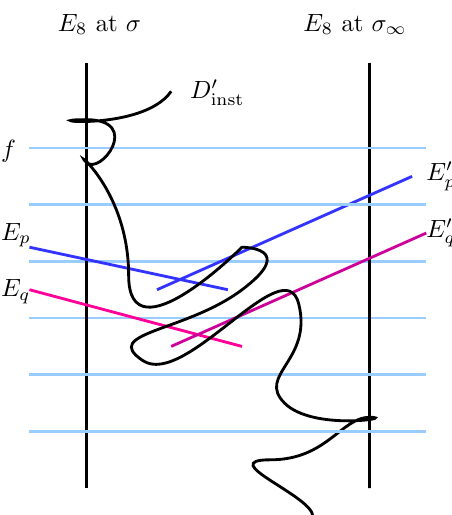
Figure 5. Two emitted instantons. All the lines in the (cid:12)gure denote P 1 , highlighting intersection structure. Vertical lines are bases locally supporting II (cid:3) curves, while horizontal lines are (cid:12)bers of Hirzebruch surface. Blow-up at some two locations of small instantons f p; q g (cid:26) (cid:27) give rise to exceptional divisors E p and E q .